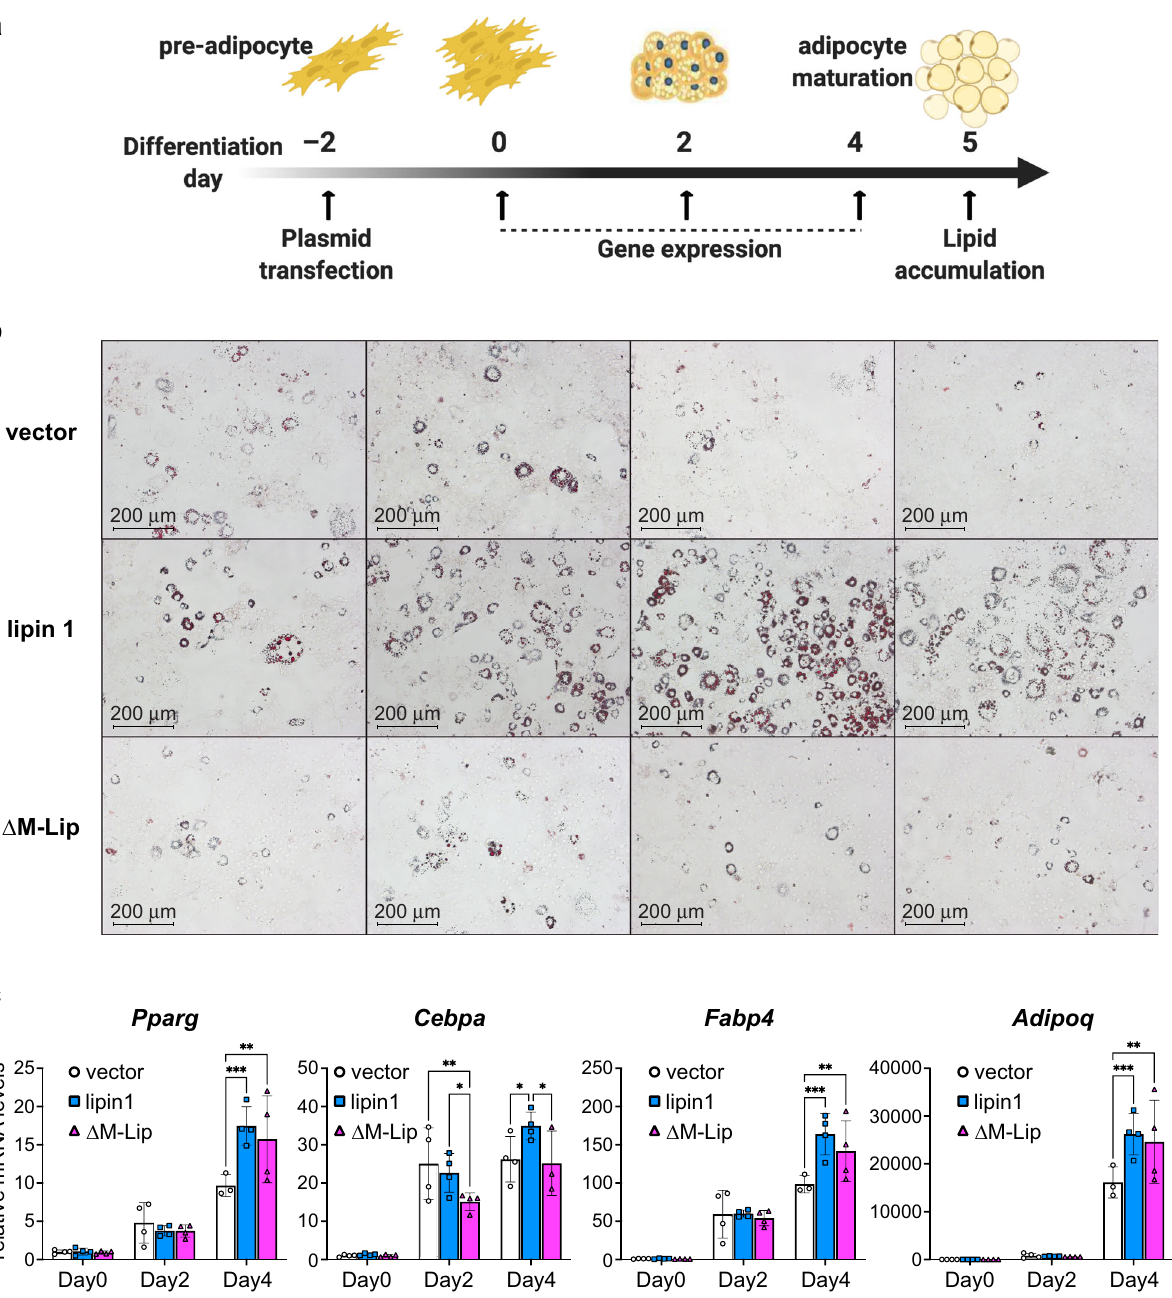
Fig. 5 Optimal lipin 1 enhancement of adipogenesis requires the M-Lip domain. a The ability of wild-type and Δ M-Lip lipin 1 to promote 3T3-L1 preadipocyte differentiation were studied by transfection with corresponding expression constructs followed by analysis of gene expression and lipid accumulation. b At day 5 after transfection, 3T3-L1 adipocytes were stained with oil red O to detect neutral lipid accumulation. Images shown are 100x magni fi cation. Scale bar: 200 μ m. n = 4 biologically independent experiments with independent replicate experiments shown in Supplementary Fig. 11b. c Expression of genes encoding adipogenic transcription factors PPAR γ ( Pparg ) and C/EBP α ( Cebpa ), adipocyte fatty acid binding protein FABP4 ( Fabp4 ), and the adipocyte hormone, adiponectin ( Adipoq ), at days 0, 2, and 4 of differentiation. Gene expression was analyzed by 2-way ANOVA, followed by paired t -tests when ANOVA results were signi fi cant. * p < 0.05; ** p < 0.01; *** p < 0.001. Data are presented as mean values ± SD. n = 4 biologically independent experiments. Source data are provided as a Source data fi Methods For Escherichia coli expression, the mouse lipin 1 (M-Lip domain, residues Plasmids . For expression in Sf9 insect cells, full-length mouse lipin 1 alpha (residues 458 – 565; M-Lip xtal , residues 458 – 548) and mouse lipin 2 (M-Lip xtal , residues 459 – 549) were cloned into pET28b using NdeI and NotI restriction sites. Mouse 1 – 891) was cloned into YM-Bac3 using SfoI and NotI restriction sites. YM-Bac3 is a lipin 1 M-Lip xtal was also cloned into ppSUMO with BamHI and NotI sites, which modi fi ed version of pFastBac Htb (Invitrogen) that contains an N-terminal 6xHis tag added a ULP1 cleavable N-terminal His-tagged SUMO fusion. followed by a Dual-Strep tag. The Δ M-Lip lipin 1 construct (residues 1 – 891 Δ 458 – 565) was generated using the overlap extension method to delete the M-Lip For expression in mammalian cells, full-length mouse lipin 1 α constructs (WT, residues 1 – 891; Δ M-Lip, residues 1 – 891 Δ 458 – 565; and Δ M-Lip xtal , residues 1 – 891 domain and create an in-frame fusion between residues 457 and 566.